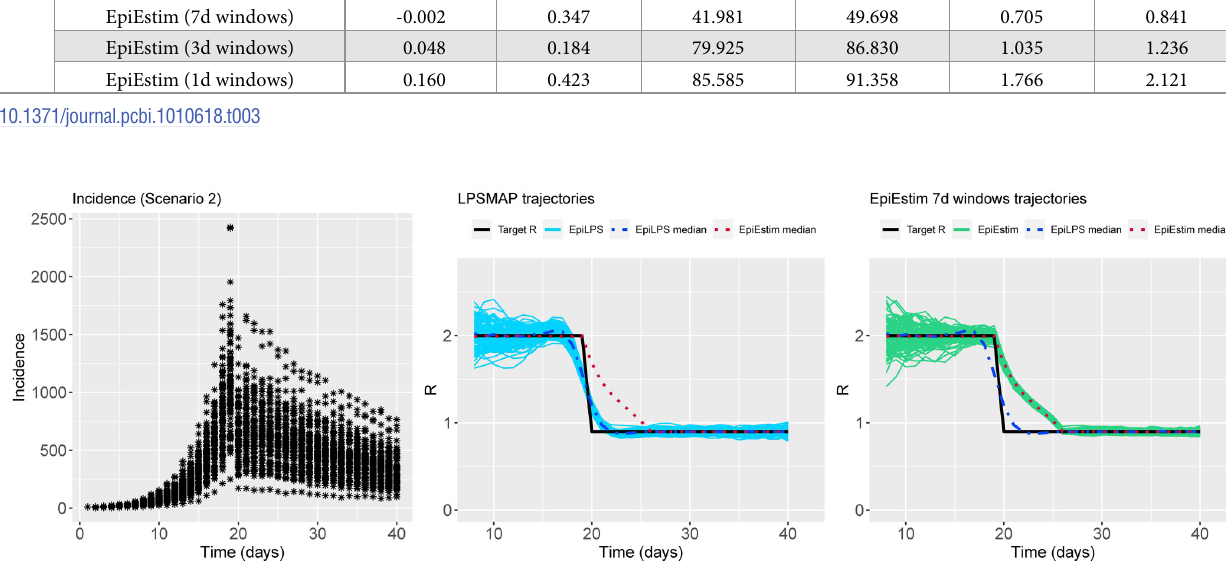
for each simulated dataset with LPSMAP. (Right) Estimated t reported at the end of the window. The pointwise median estimate of R t